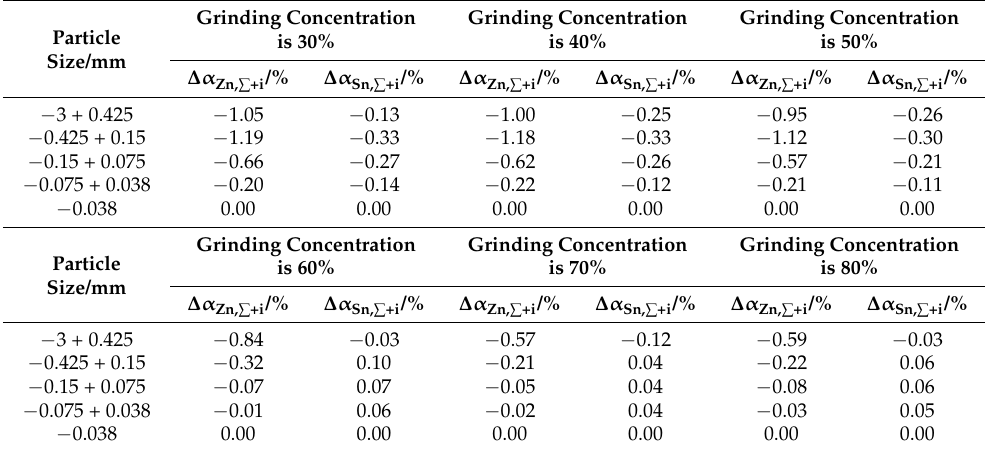
Figure 4. Changes in the cumulative grades of Zn and Sn for different size fractions and grinding concentrations. ( a ) Zn cumulative grade. ( b ) Sn cumulative grade. Table 6. Results of changes of cumulative grade with different grinding